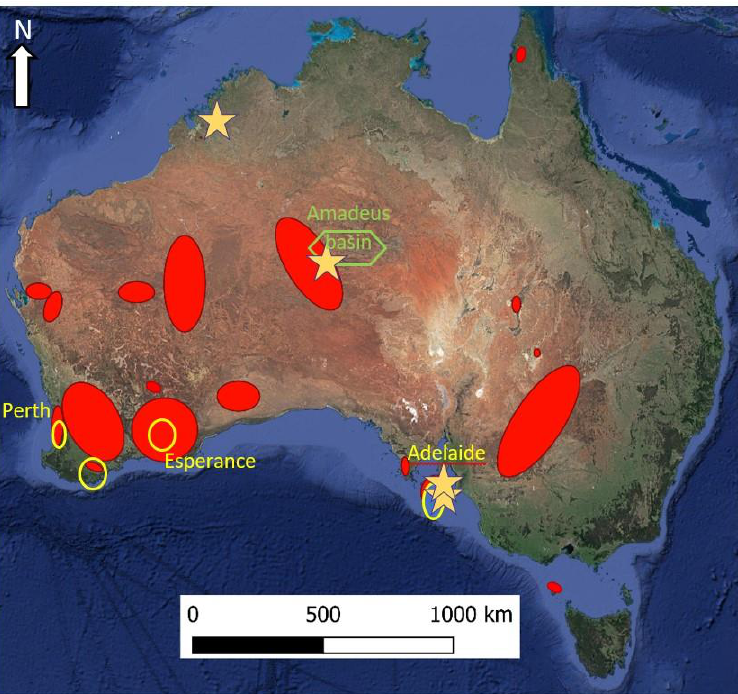
Figure 5. Location of the areas with many circular depressions in Australia (red areas). The yellow stars are the location of the wells that found H 2 , the yellow circles highlight the areas where depressions that look like fairy circles can be observed and where statistic has been done in this study.